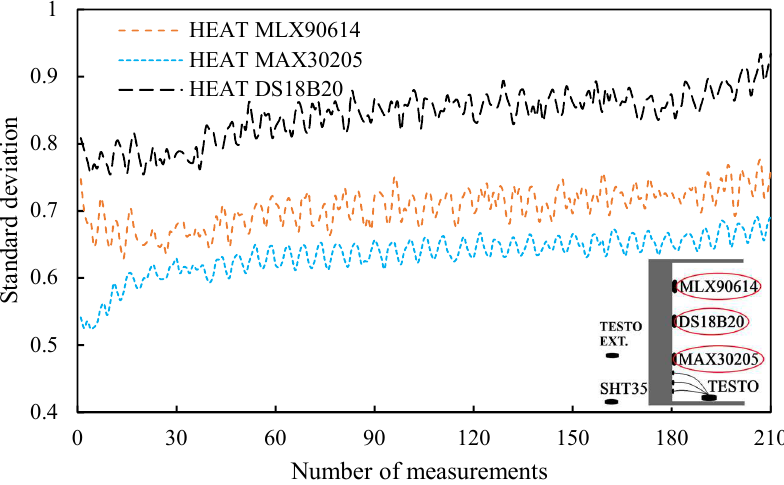
Figure 12. Standard deviations of the surface temperature measurements captured by sensors of the HEAT MAX3020, HEAT DS18B20, and HEAT MLX90614.